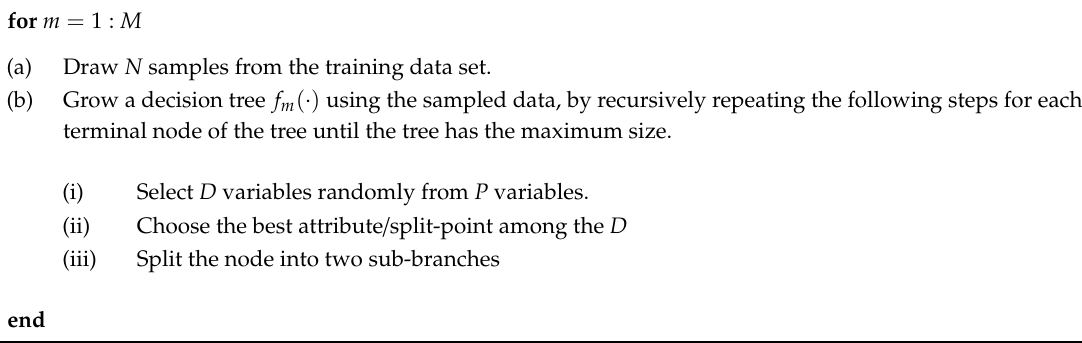
Algorithm 1. RF learning algorithm: Learning algorithm of random